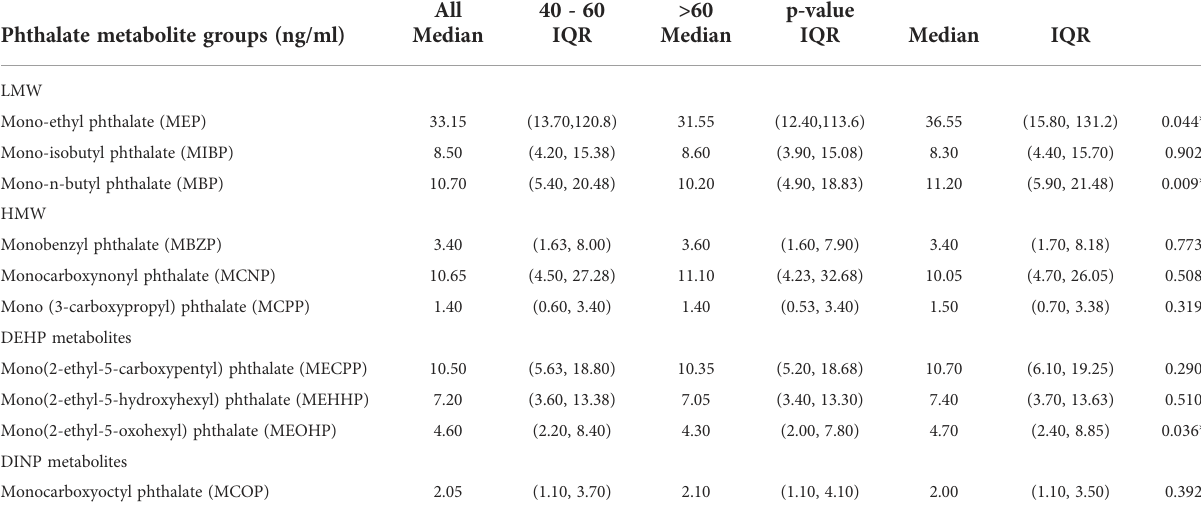
TABLE 3 Phthalate metabolite group medians and interquartile ranges (IQR) strati fi ed by age, NHANES 2013-2016.